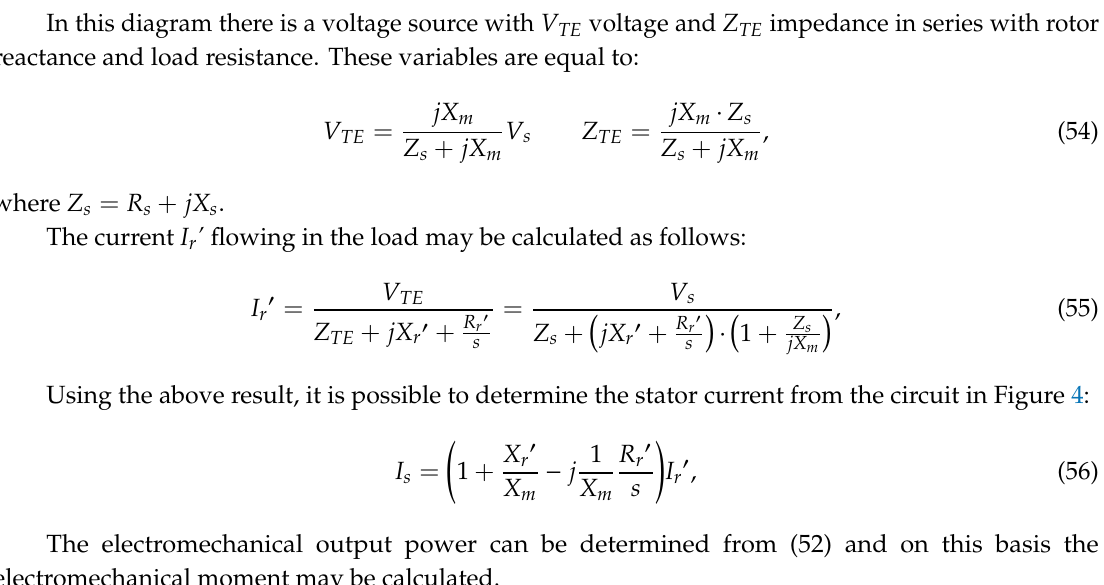
Figure 5. Steinmetz T-equivalent diagram of induction motor after using Thevenin’s Theorem.